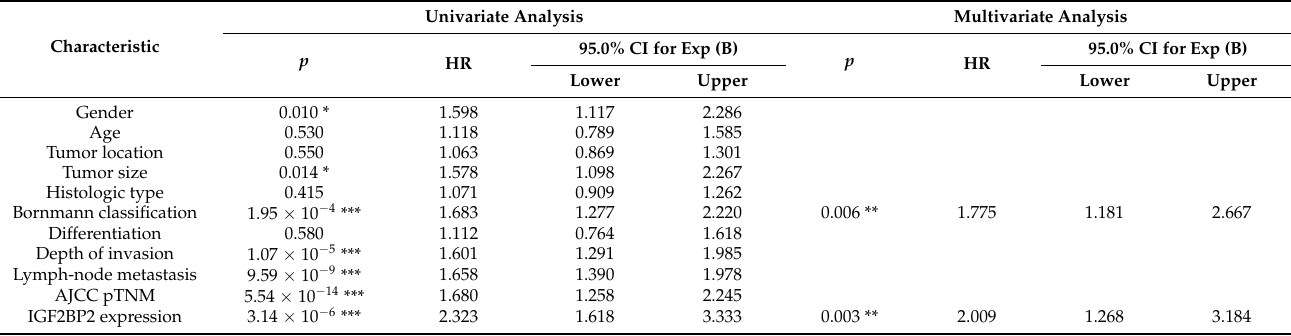
Table 3. Relapse-free survival analyzed using Cox proportional-hazard